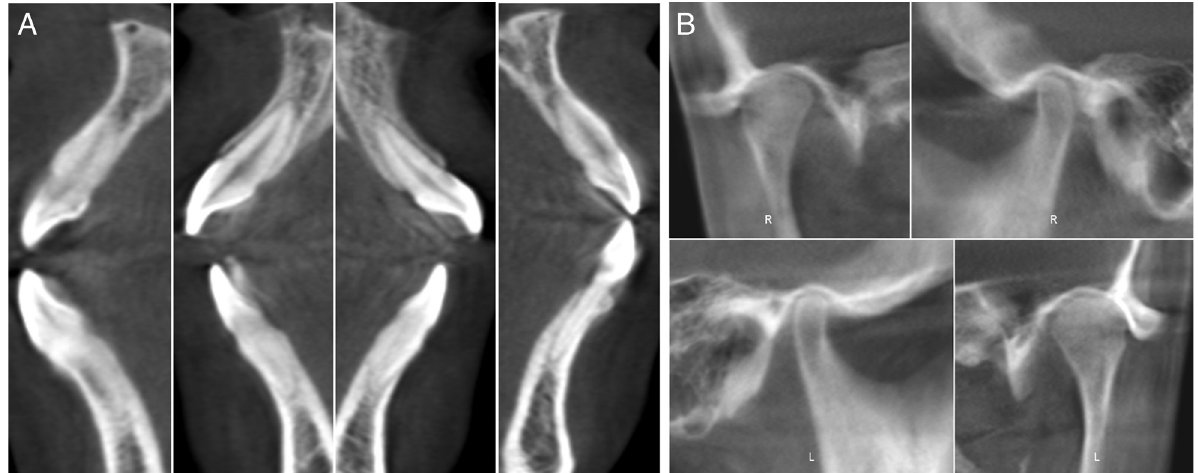
Figure 3. The pre-treatment labial and lingual bone volume of anterior teeth (A) and temporomandibular joint radiograph